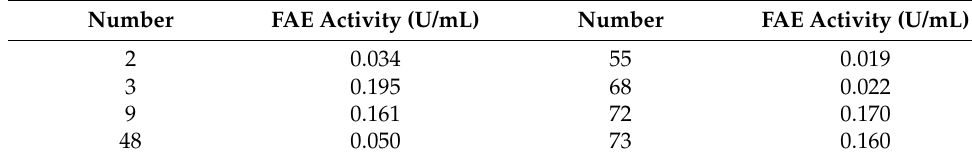
Table 1. FAE activities of